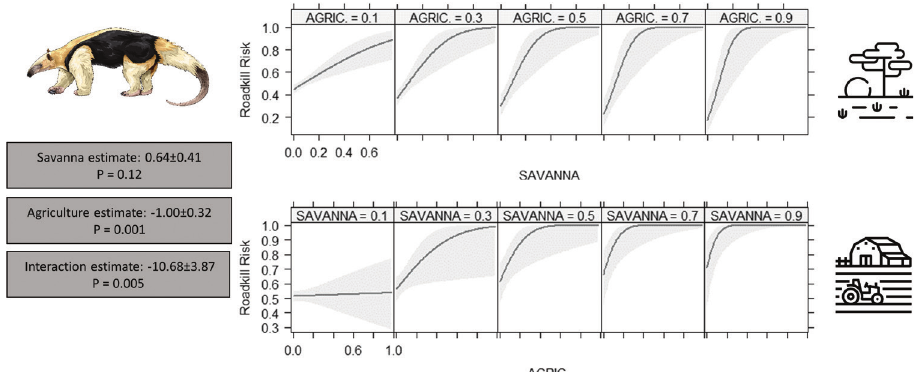
Figure 7. Best model selected by AIC for T. tetradactyla and its estimated coefficients. The roadkill risk is negatively related to agriculture. However, the interaction between agriculture and savanna was significant, which changes the effect direction of agriculture in the presence of more savanna areas, increasing the risk of roadkill with the increment of agriculture, in other words, landscapes with savanna and agriculture mosaics are more likely to have collared-anteaters